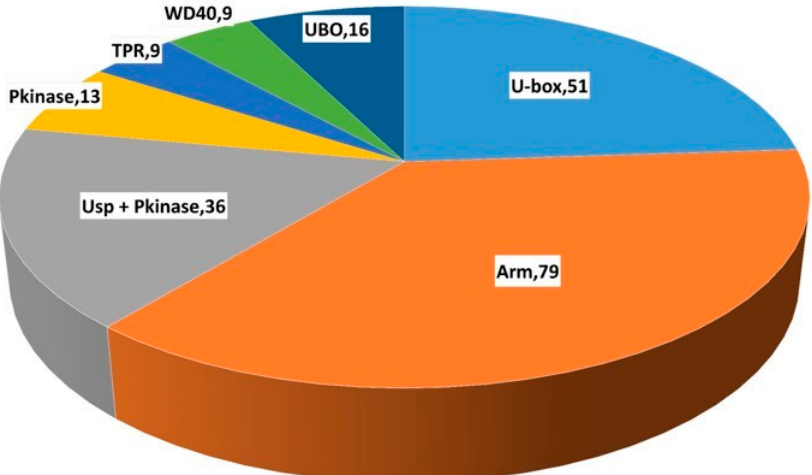
Figure 1. Classification of wheat U-box genes based on functional domains. The number and type of U-box E3 genes are shown. U-box: U-box E3 genes containing only the U-box domain; Arm: armadillo (Arm) repeat; Usp + PKinase: ubiquitin specific protease and protein kinase; PKinase: protein kinase; TPR: tetratricopeptide repeat; WD40: WD40 repeat; UBO: U-box containing small numbers of other specific domains such as protealysin propeptide (PLN_propep), ubiquitin elon- gating factor core (Ufd2P_core), zinc-binding domain (zf-CCHC_2), cyclophilin-type peptidyl-prolyl cis-trans isomerase (Pro_isomerase), and